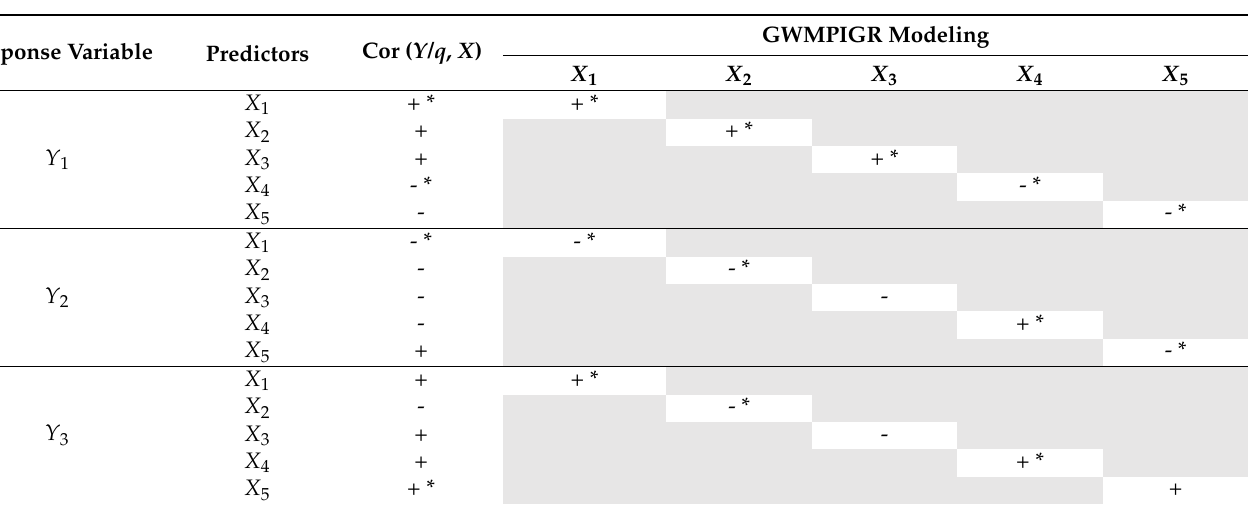
Table 6. The comparison of signs between correlation and regression parameters coefficient of the GWMPIGR model for Surabaya